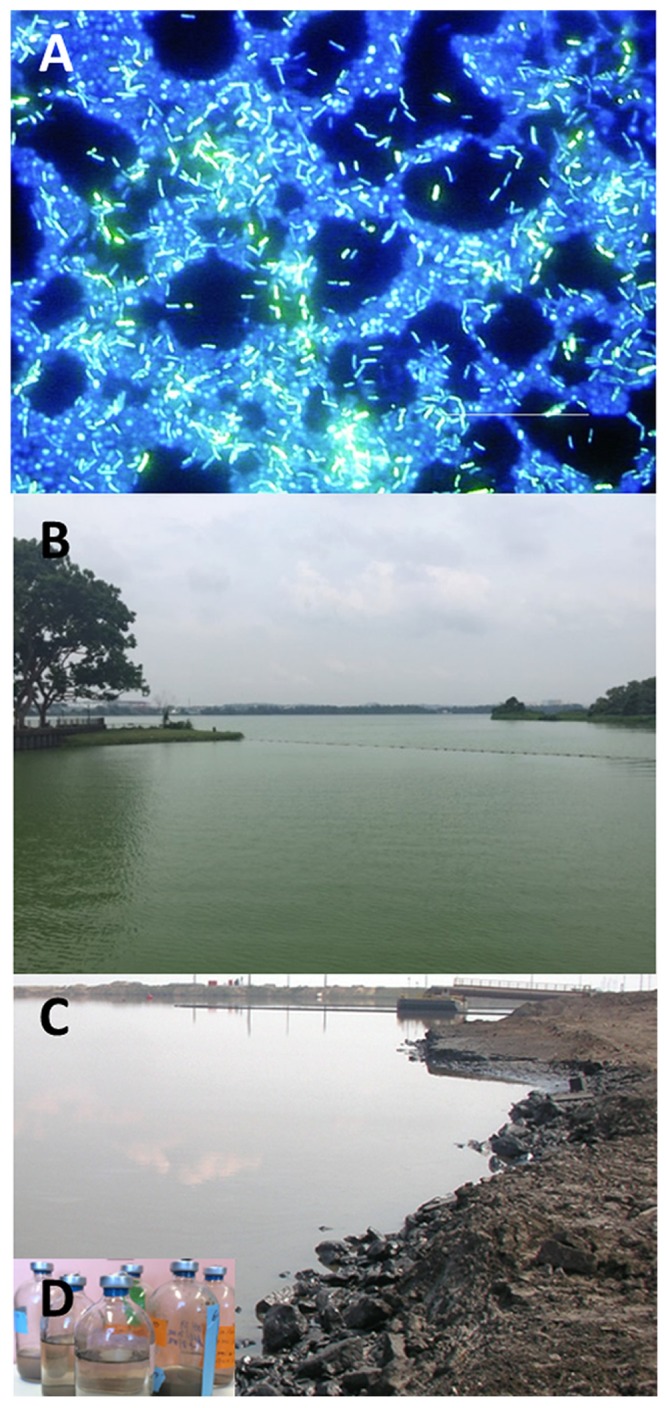
Environments where studies of water quality have been advanced by NGS. (A) Fluorescence microscopy showing biofilm grown on a stainless steel surface in a laboratory potable water biofilm reactor for 14 days (image from Donlan, 2002). Drinking water is thought to contain a mixture of both planktonic and dissociated biofilm bacteria. Using NGS methods, a repertoire of microbial species including potential pathogens have been detected in water distribution systems, raising the concern of the effectiveness of water treatment on microbial water safety. (B) A water reservoir in Singapore impacted by a cyanobacterial bloom characterized by Penn et al. (2014). With global warming, cHAB is predicted to occur more regularly with likely severe consequences (e.g., toxin loading) that can diminish water quality. (C) An oil sands tailings pond in Alberta, Canada characterized by Tan et al. (2015). Inset (D) shows microcosms established to study degradation of unrecovered hydrocarbons deposited in oil sands tailings pond. NGS has been used to characterize the microbial communities in oil sands tailings ponds (http://www.hydrocarbonmetagenomics.com/) in order to better understand mechanisms of pollutant degradation.